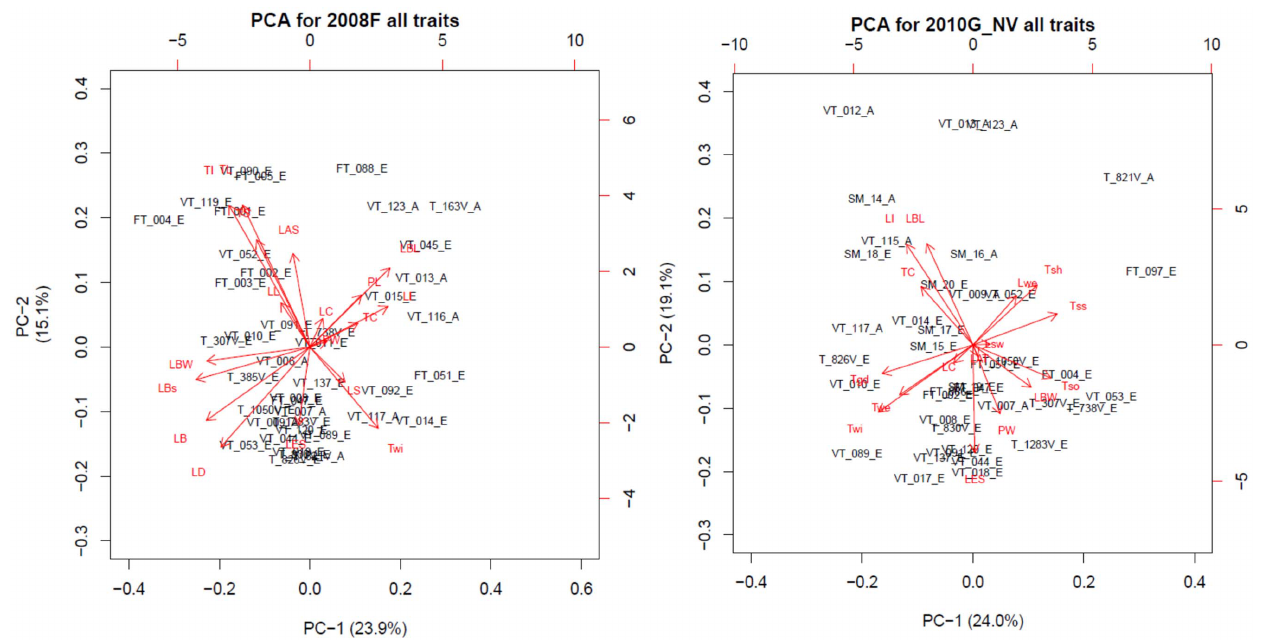
Figure 5. Principal component analysis (PCA) diagram showing the phenotypic variation and the contribution of different traits for the tested turnip accessions of the field experiment in 2008 (2008F) and the greenhouse experiment in 2010 (2010G). The presented traits are leaf color (LC), leaf length (LL), lamina blade length (LBL), lamina blade width (LBW), leaf index (LI), petiole length (PL), petiole width (PW), leaf lobe (LB), leaf lobelets (LBs), leaf edge shape (LES), leaf blade shape outline (LS), leaf division (LD), leaf apex shape (LAS), leaf hairiness (LH), leaf lamina attitude (LAT), leaf and stem weight (Lwe), flowering time (FT), tuber length (TL), tuber width (Twi), tuber index (TI), tuber shape (TS), tuber color (TC), tuber shoots number (Tsh), tuber weight (Twe) tuber surface smoothness (Tss), tuber swelling onset (Tso) and tuber growing depth (Tgd). Red arrows represent the contribution of different traits to the total variation. Percent of variation explained by each dimension is indicated. The name of accession with either _A or _E extension refers to Asian or European subpopulation, respectively.